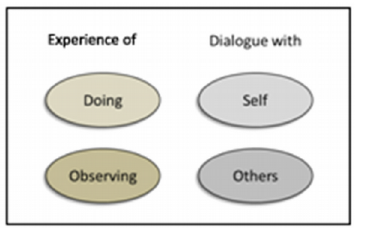
Figure 3. Active Learning approach (Fink, L.D., 2003)